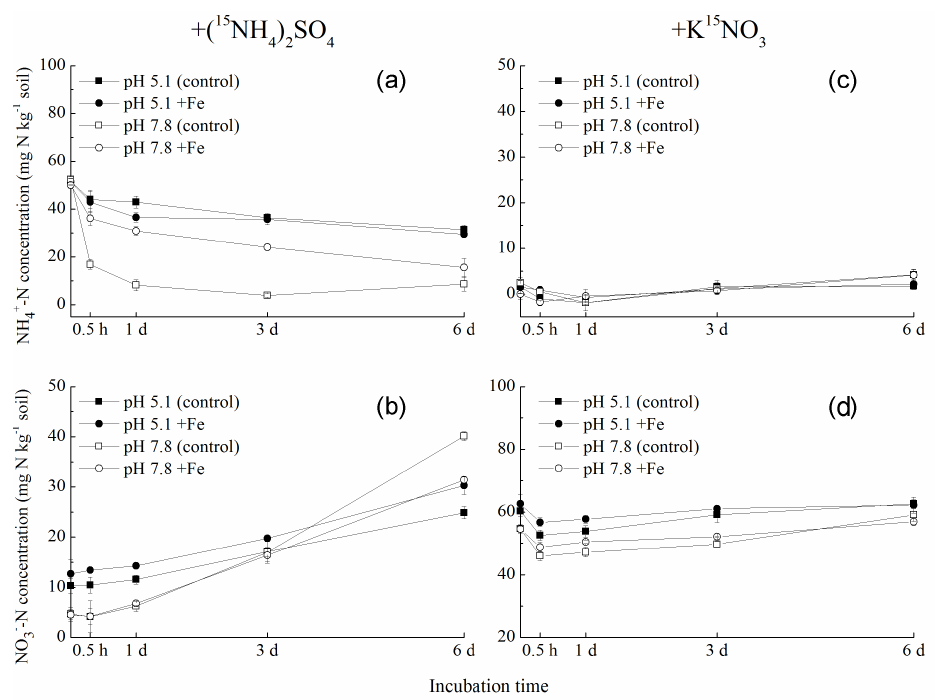
Figure 2. Effects of Fe oxide on NH + -N and NO − -N dynamics during 6 days by 15 N tracing incubation at 28 ◦ C with soil moisture at 100% 4 3 WHC. NH + -N and NO − -N concentrations were measured following the addition of 50mgNkg − 1 ( 15 NH 4 ) 2 SO 4 ( a and b ) and K 15 NO 3 ( c 4 3 and d ). Error bars represent standard deviation; n = 3.